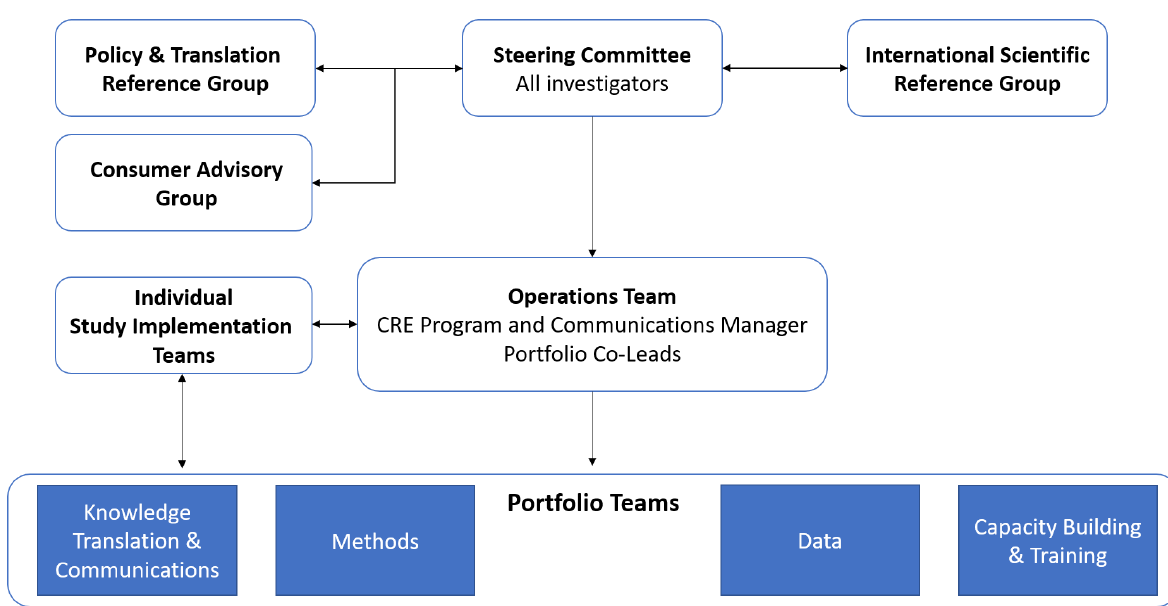
Figure 1: MI-CRE Governance